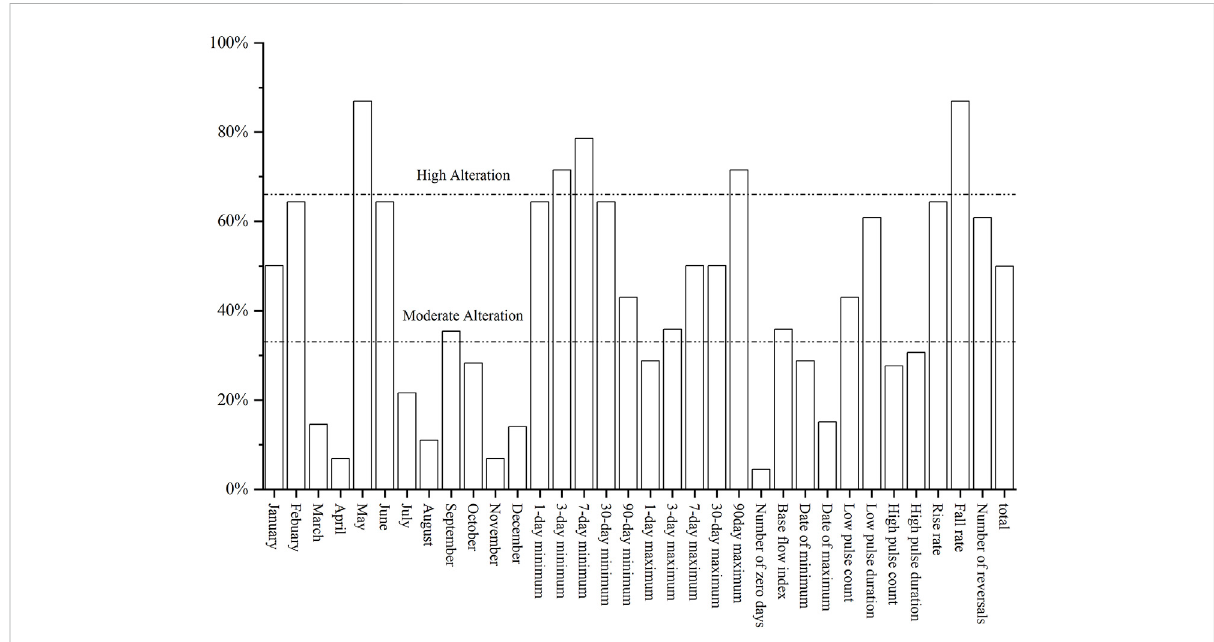
FIGURE 9 Hydrologic alteration of the RVA for CHS (the number represents the IHA indicator, and the total represents the overall degree of change).